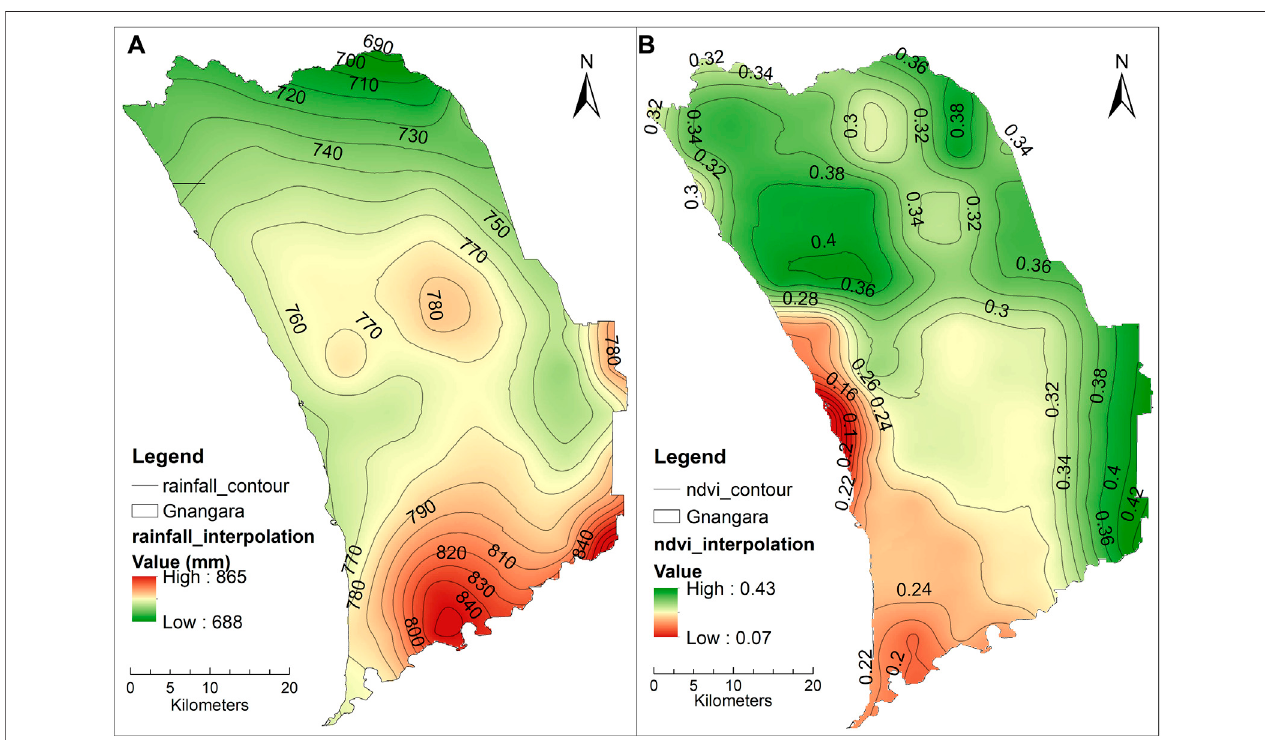
FIGURE 3 | Contour map of the rainfall (A) and NDVI (B) in the Gnangara